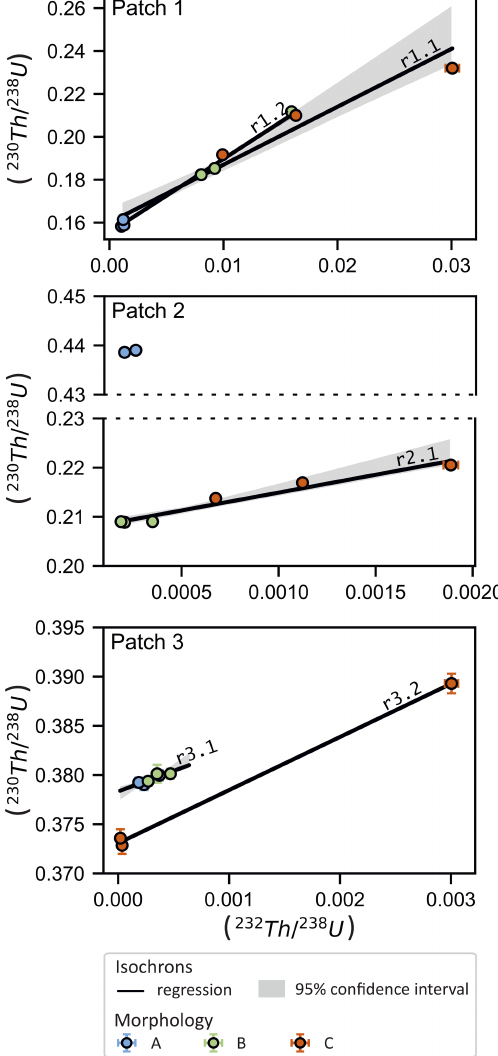
Figure 4. Isochron plots of 238 U-normalised thorium measure- ments of each CCC patch. Colour represents morphological type. The shaded area represents the 95% confidence interval of the re- gression slope and intercept. Regression lines are labelled with an identification number corresponding to Table